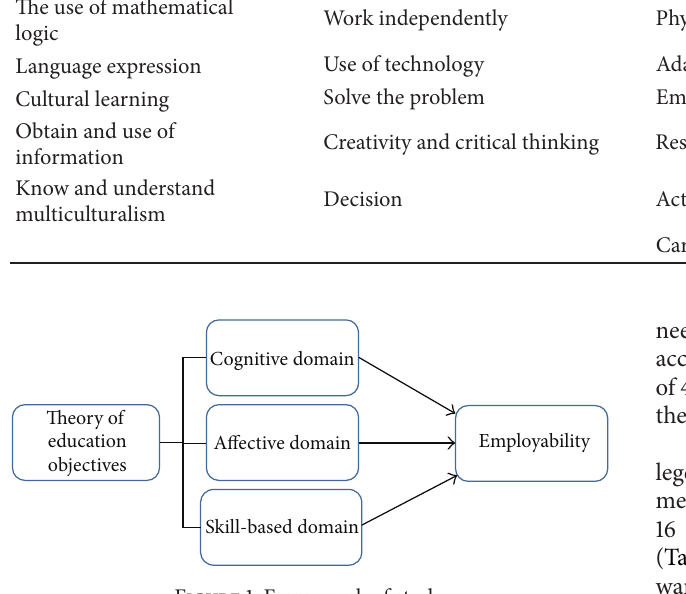
Figure 1: Framework of